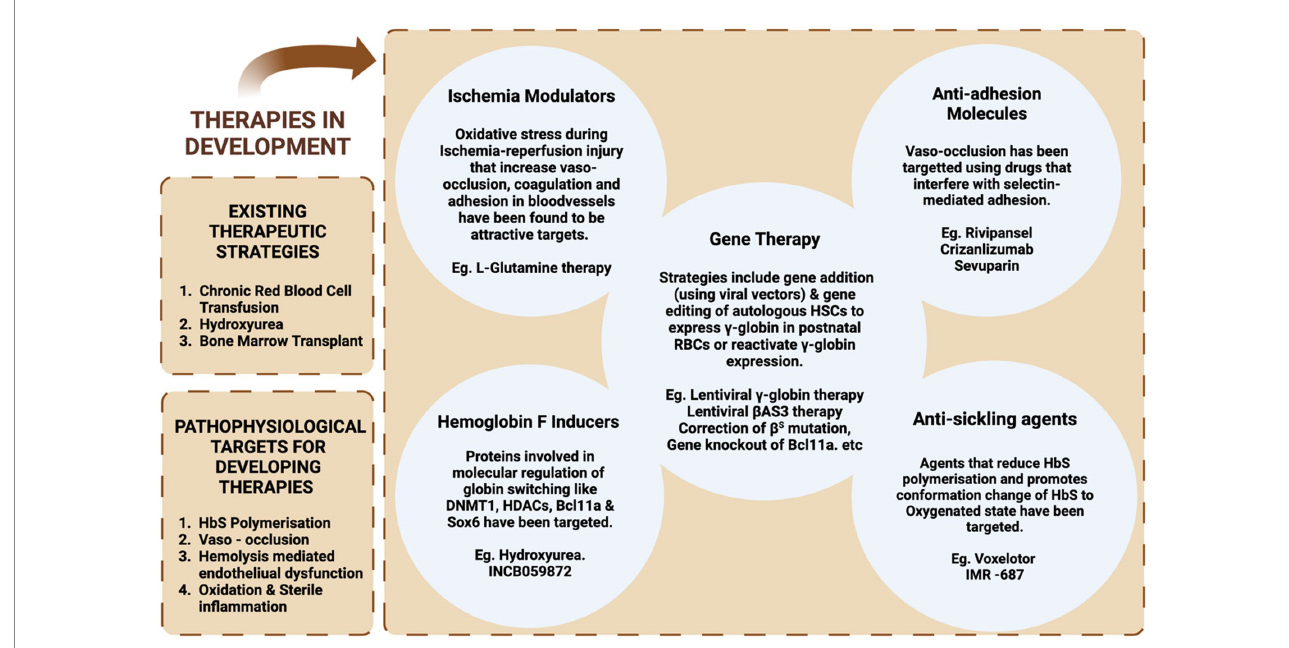
FIGURE 3 A diagrammatic representation of various therapeutic strategies: current and under development for the treatment of